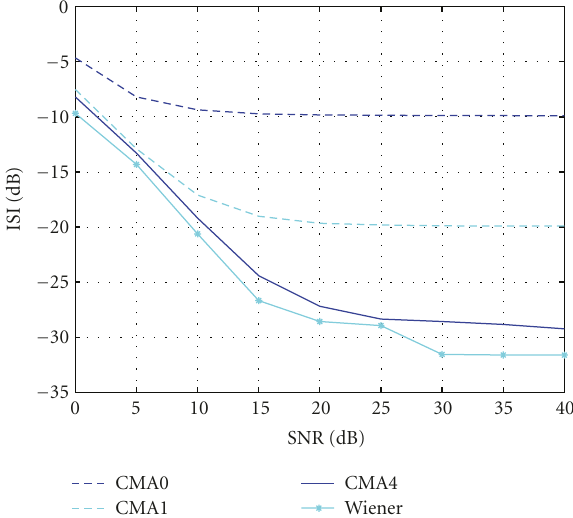
Figure 6: CMA ISI performance for di ff erent single spike initializa- tions and